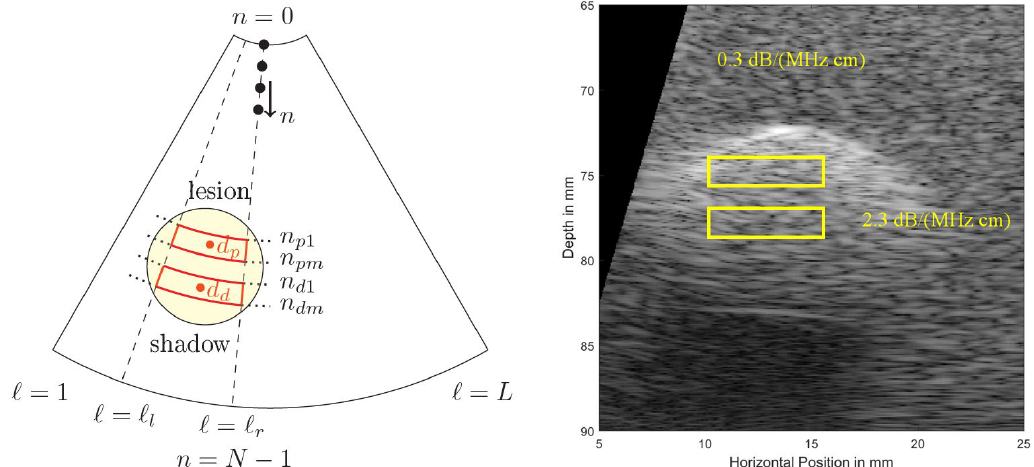
Figure 5. ( Left ): To define locations and indices within a sector scan used in the estimation algorithms. At the top the US transducer is assumed operating as a phased array. ( Right ): Simulated US B-mode image, exhibiting typical US speckles and shadowing behind a strongly absorbing region (a simulated lesion). Distal (bottom, subscript (...) d ) and proximal (top, subscript (...) p ) windows are